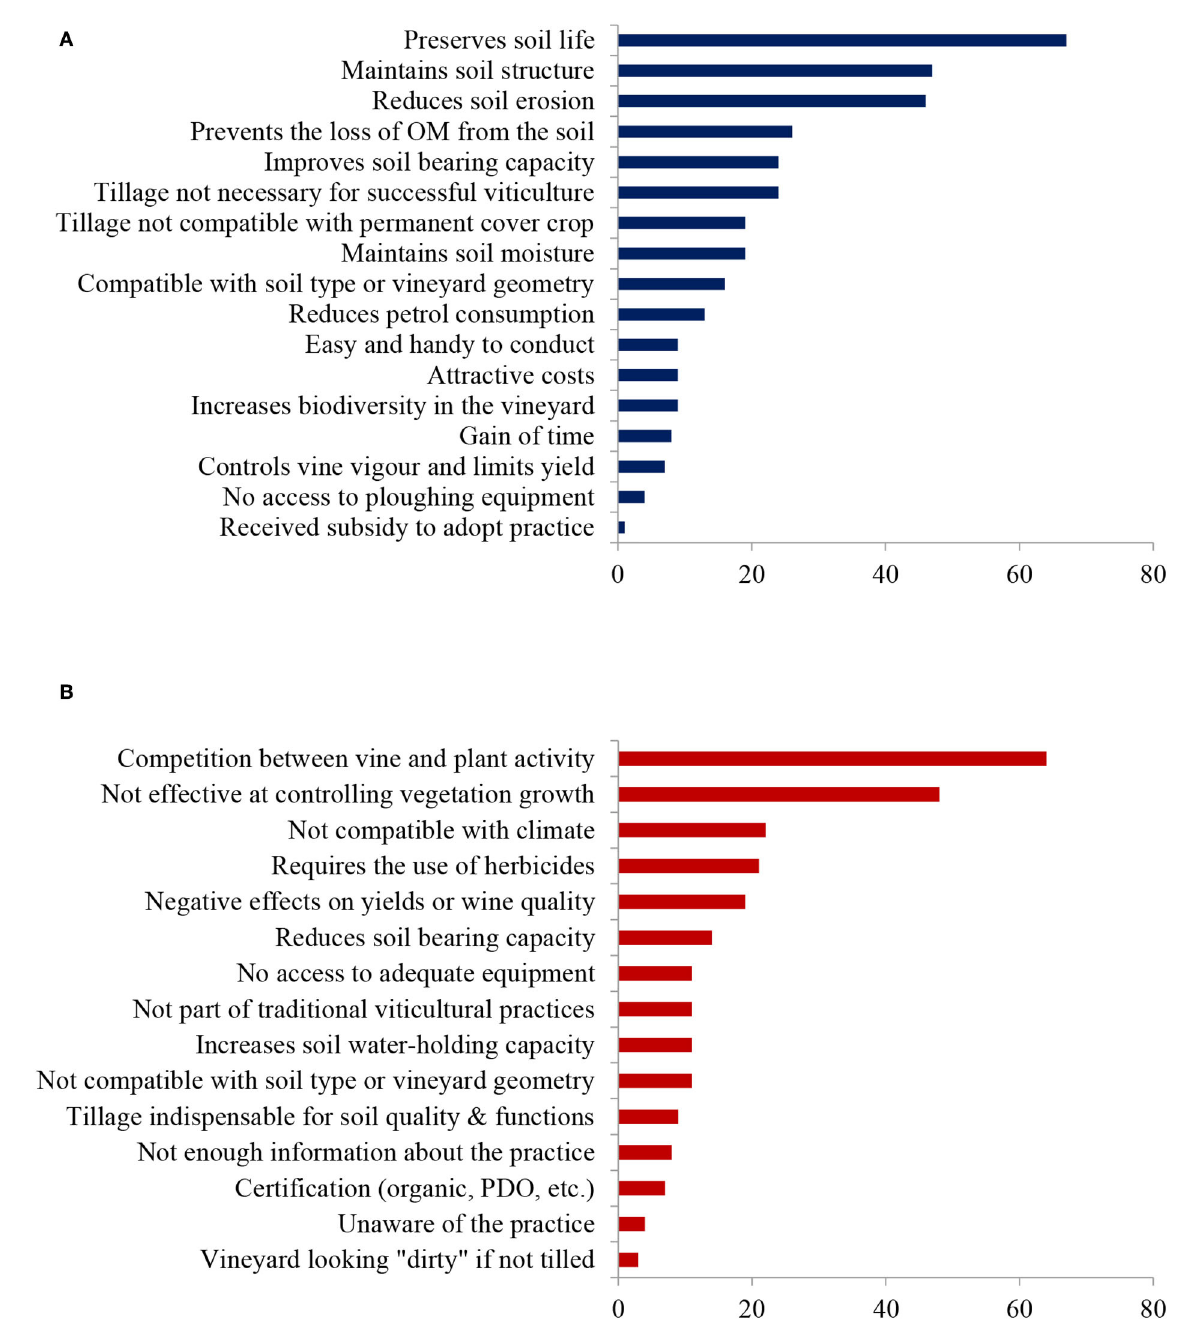
FIGURE4 Motives (A) and barriers (B) to the adoption of no-tillage in viticulture in France ( n = 201 and 186, respectively). Several responses were possible for each respondent. OM, organic matter; PDO, protected designation of origin.